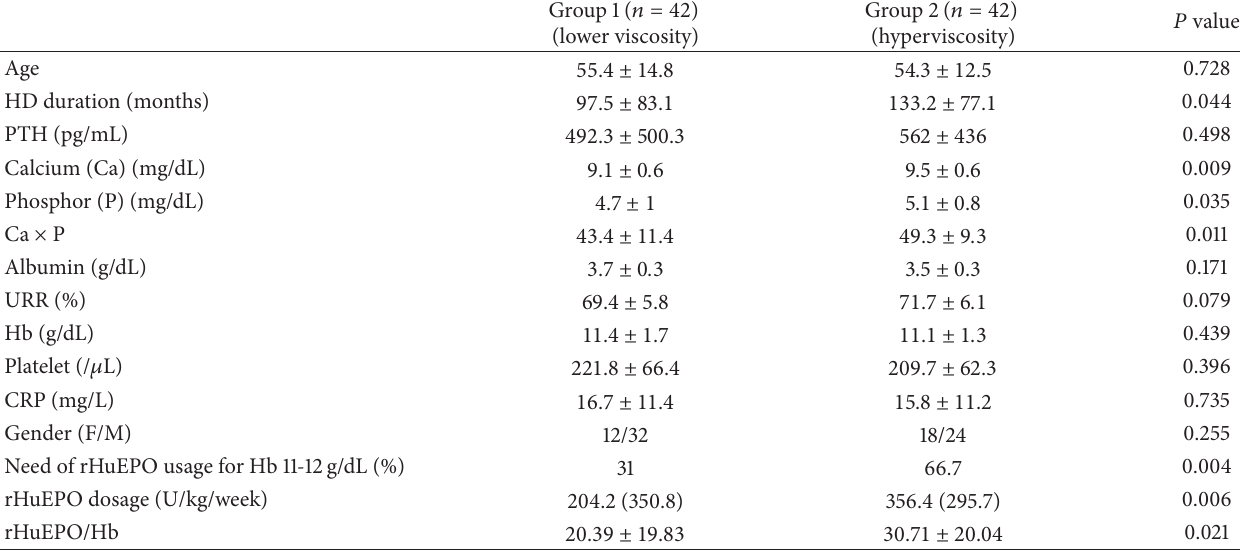
Table 2: Demographic and biochemical characteristics of the study groups.